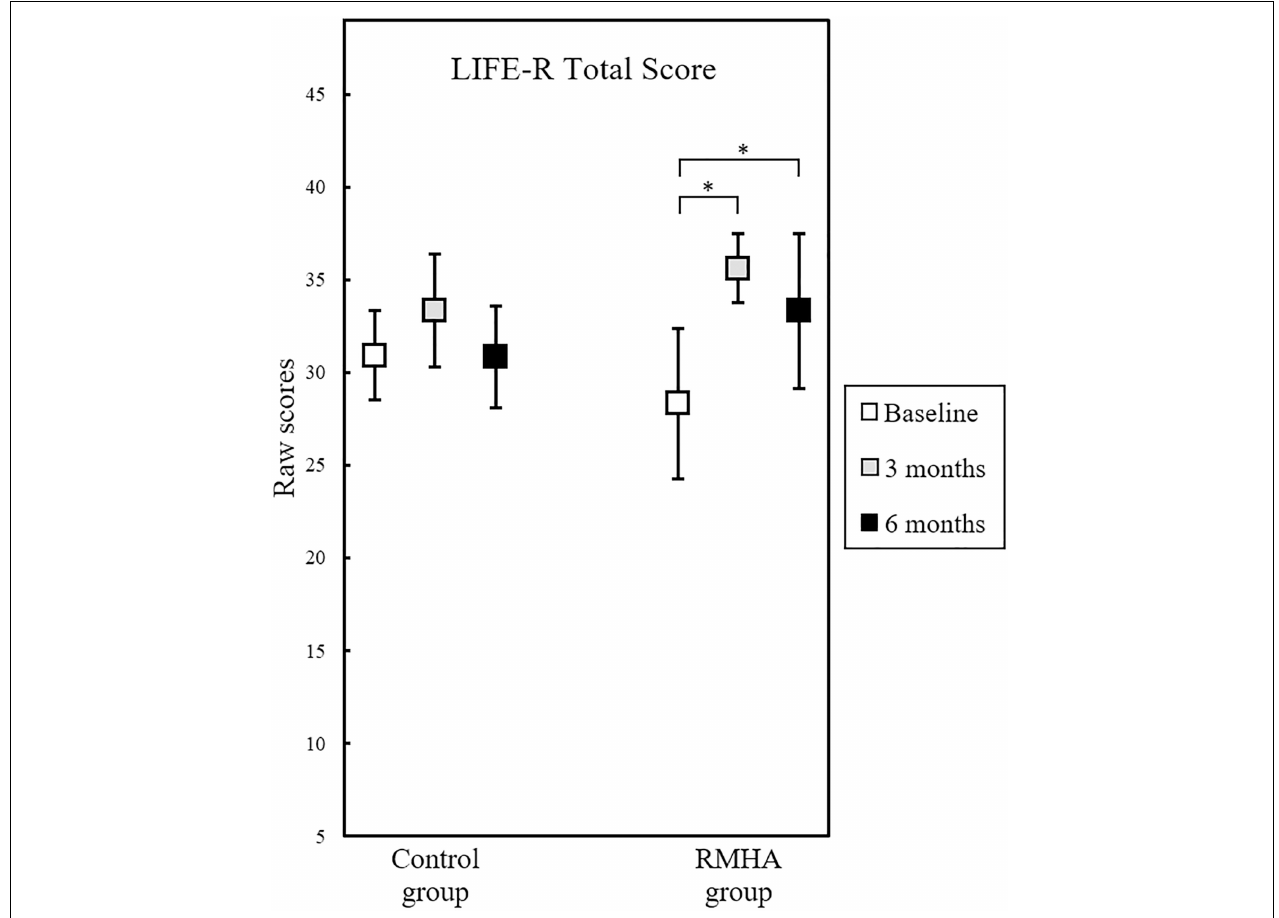
FIGURE 2 | Plots of mean scores in the LIFE-R Total Score, for 12 controls and 13 RMHA children, at baseline, 3 and at 6 months. Error bars represent a 95% CI of the mean. The scores of the intervention group significantly improved from baseline to 3 months, as well as from baseline to 6 months. This was a non-standardised questionnaire, therefore there was no indication of a cut-off for abnormal performance. CI, Confidence Interval; LIFE-R, Listening Inventory for Education – Revised; RMHA, Remote Microphone Hearing Aid. ∗ p < 0.05.